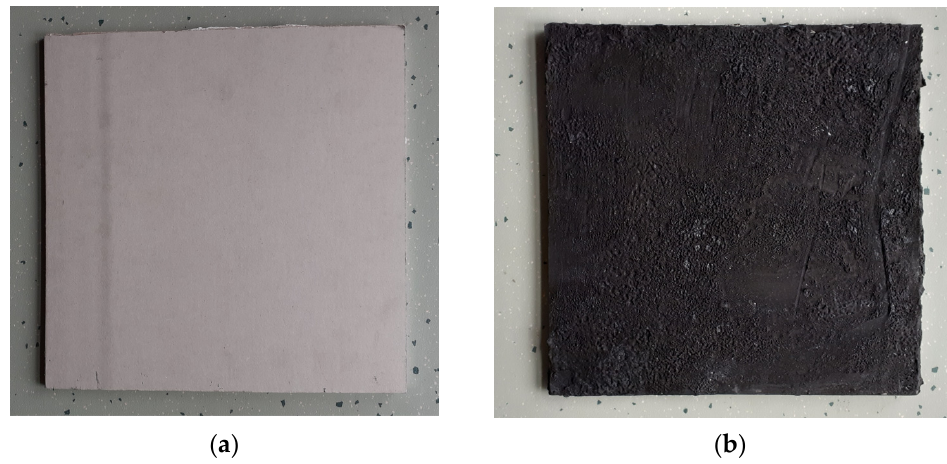
Figure 1. ( a ) Drywall panel; ( b ) drywall panel coated with several layers of biochar paste.